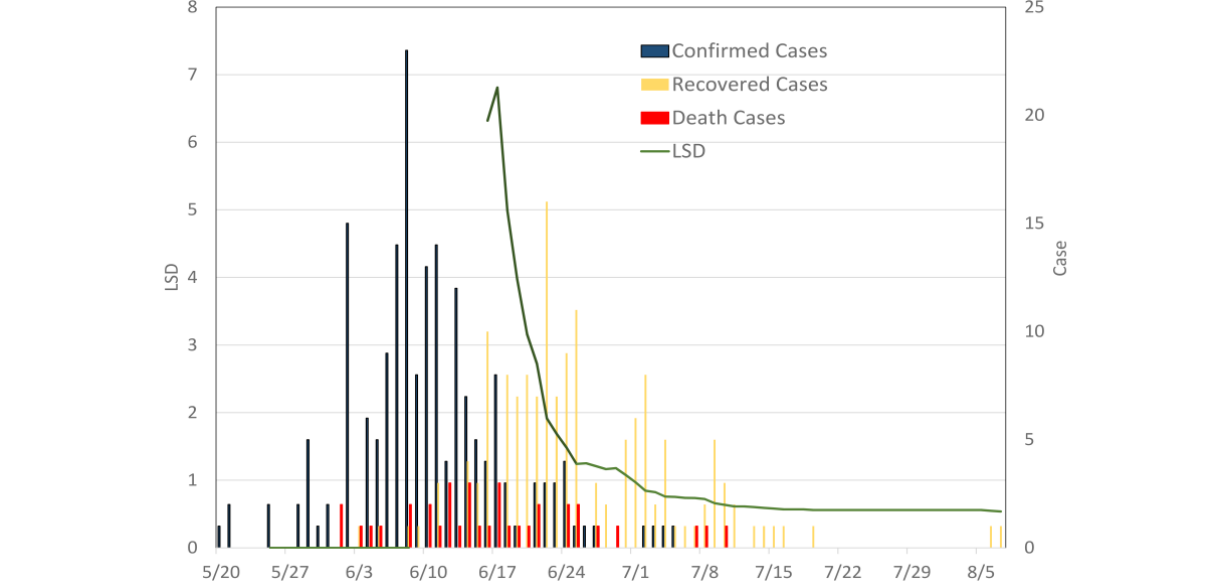
Figure 6. LSD index for the Middle East respiratory syndrome–related coronavirus outbreak in South Korea, 2015. The LSD index greater than 6 was estimated on June 16, 2015. After about 2 weeks, the LSD index was less than 1 on July 1, 2015, and kept at a low value until the end of the outbreak. LSD: lifted social distancing.